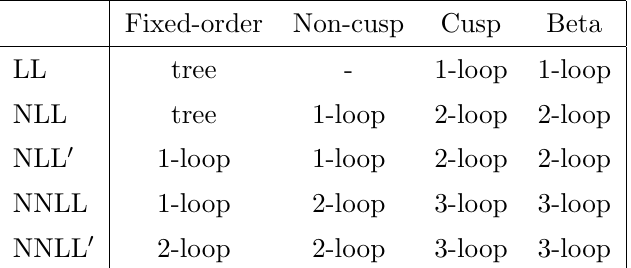
Table 3 . Perturbative ingredients needed at di(cid:11)erent orders in resummed perturbation theory. The columns correspond to the loop order of the (cid:12)xed-order ingredients, the non-cusp and cusp anomalous dimensions, and the QCD beta function.